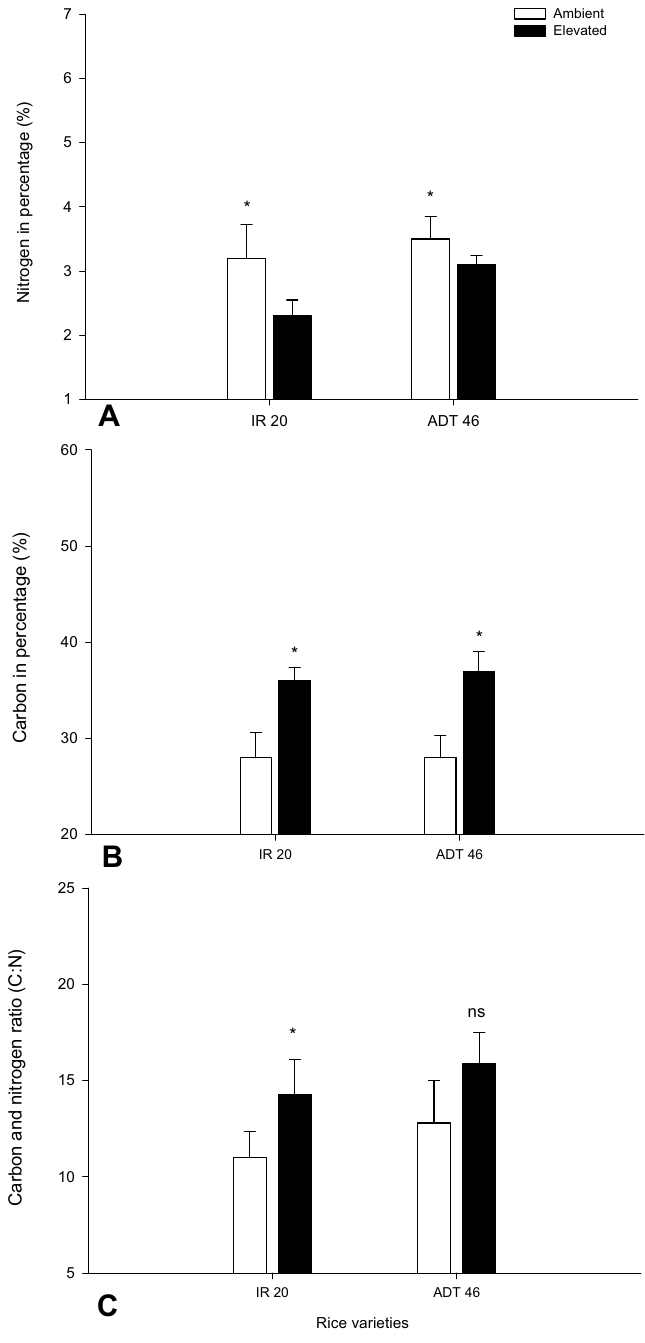
Figure 3. Effect of e CO 2 on biochemical profile of different rice varieties ( A - Nitrogen, B - Carbon, C - Nitrogen and Carbon ratio) (Values are means ± SEM of five replications) (Mean (± SEM) followed by the symbol * in an individual experiment indicate significant difference (P < 0.05) in a Tukeys test) (ns-non